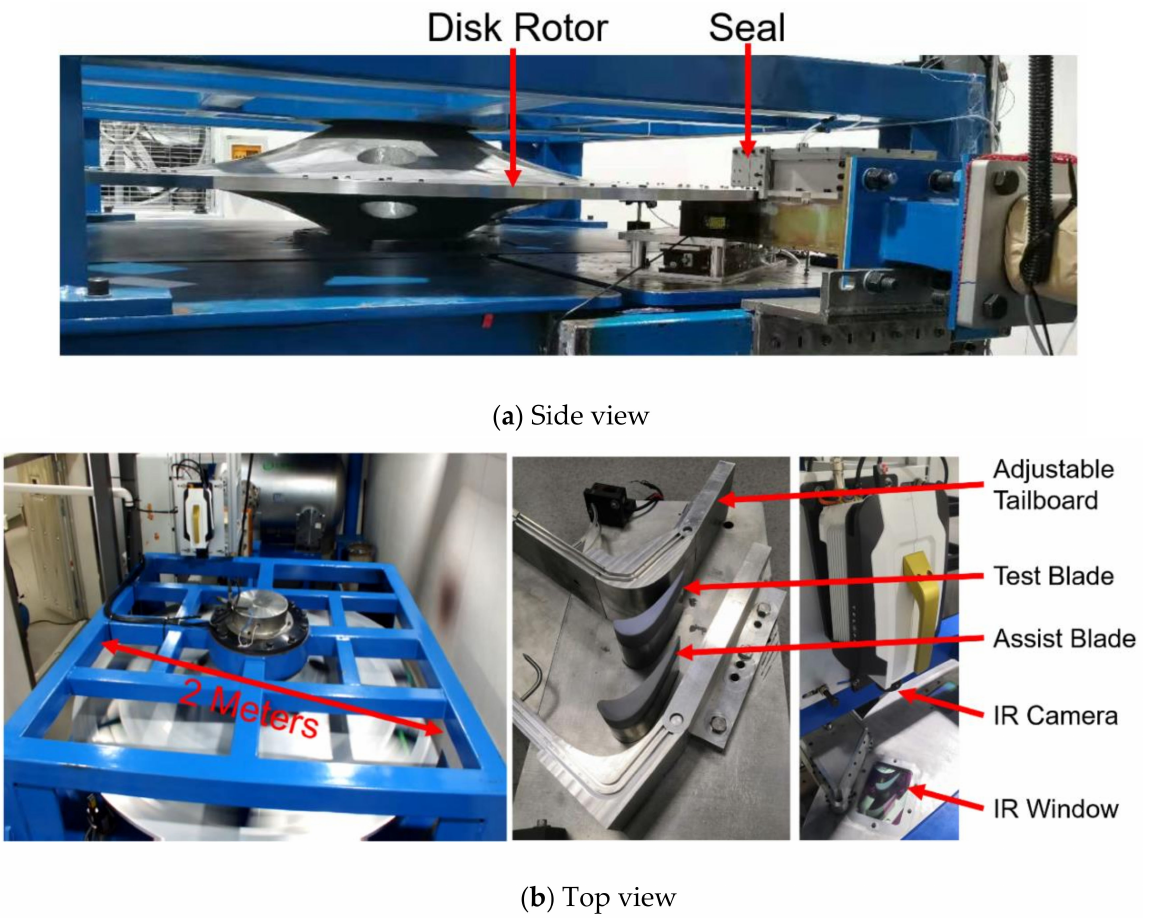
Figure 12. 2-Passage linear cascade mounted at high-speed disk rotor experimental rig. Both an aerodynamic test and a thermal test are carried out in the large-scale linear cascade rig. The schematic diagram of the test section is shown in Figure 13. The